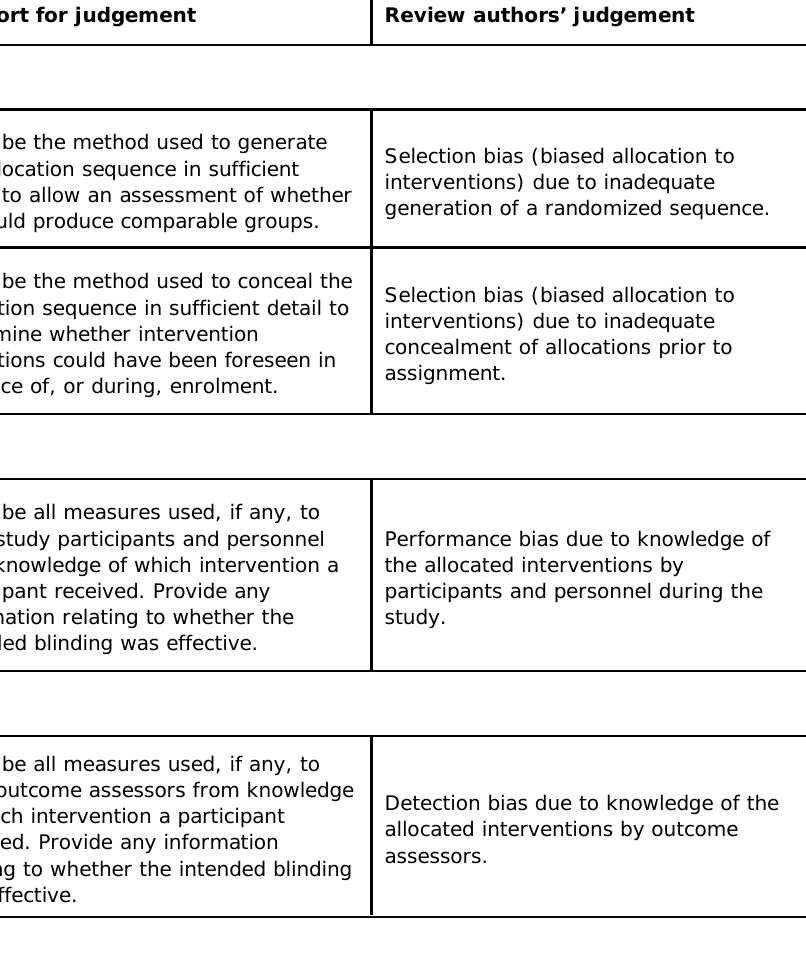
Table 2. The Cochrane collaboration tool to assess the risk of